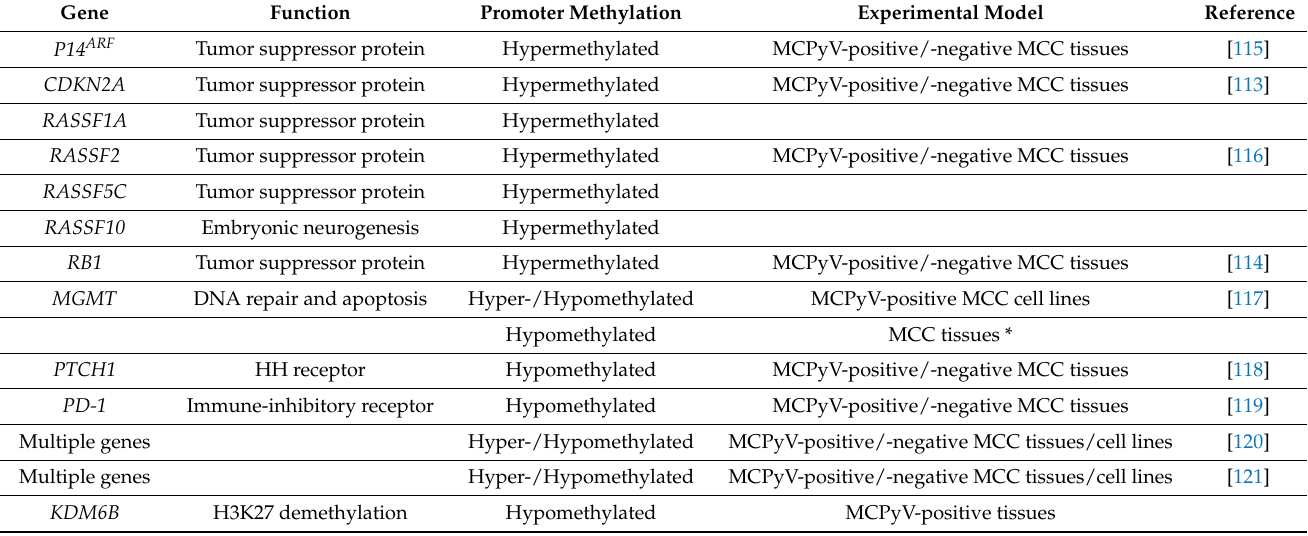
Table 2. Differentially methylated genes in Merkel cell polyomavirus (MCPyV)-positive Merkel cell carcinoma (MCC) tissues and/or MCPyV-positive MCC-derived cell